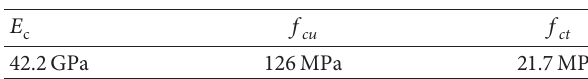
Table 2: Mechanical properties of UHPC.